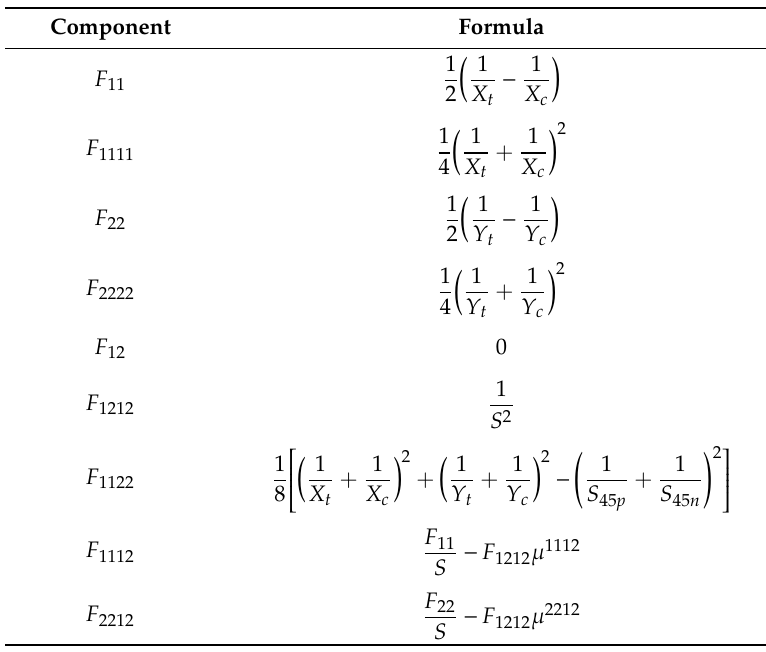
Table 3. Tensorial components attainable through the presented criterion.